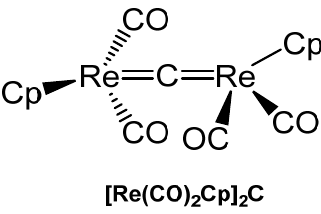
Figure 37. Structural representation of the Re carbido complex [Re(CO) 2 Cp] 2 C.